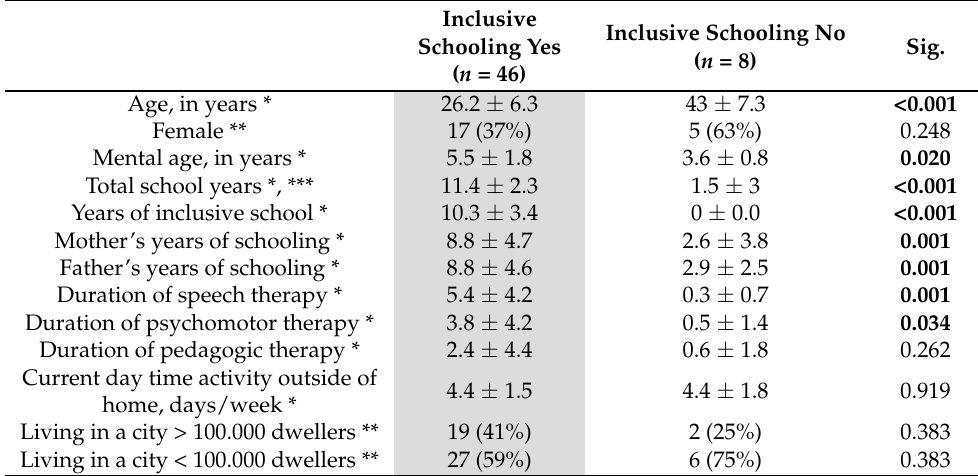
Table 2. Patient characteristics in DS individuals who attended (light grey) or did not attend (white) inclusive schooling.